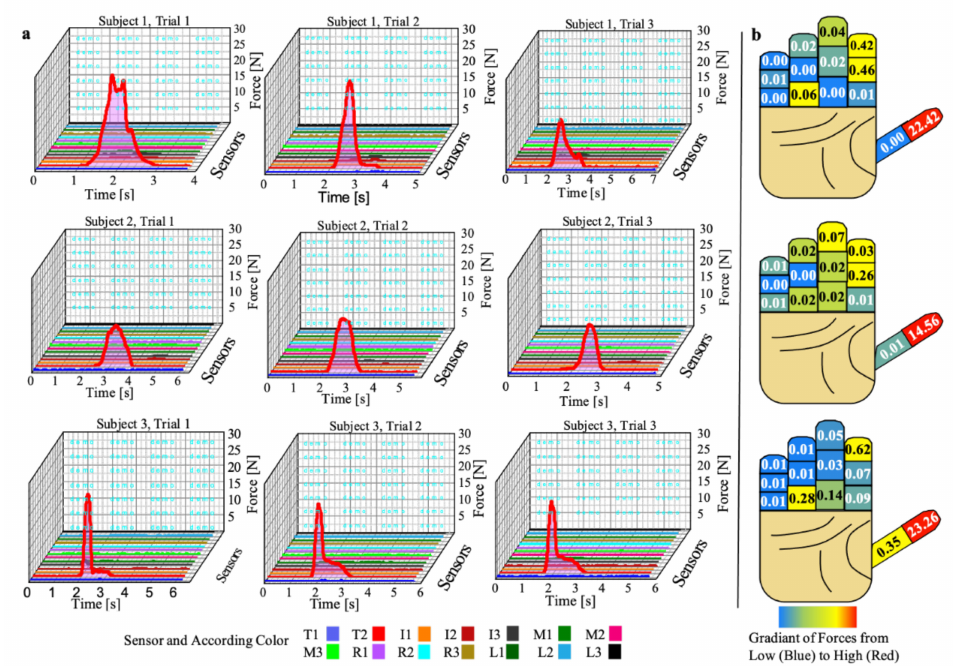
Figure 8. Key turn results and analysis: ( a ) graphs of force during key turn task with three subjects and three trials and ( b ) average maximum value during those three trials with a heat map of forces represented at each